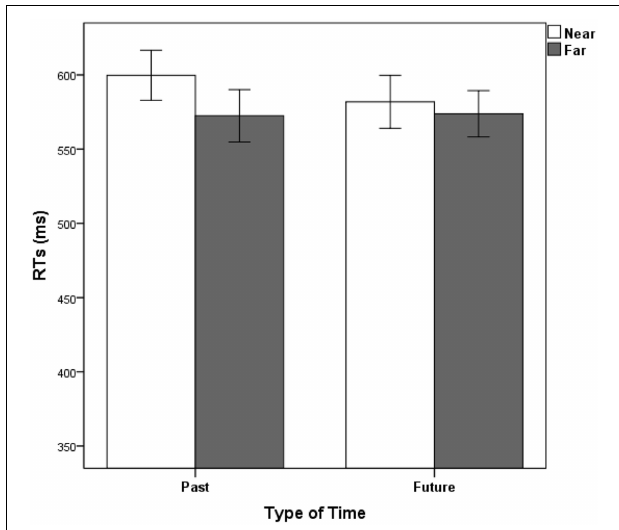
FIGURE 4 | Mean RTs in Experiment 4 as a function of type of time and distance. Error bars represent standard errors of the